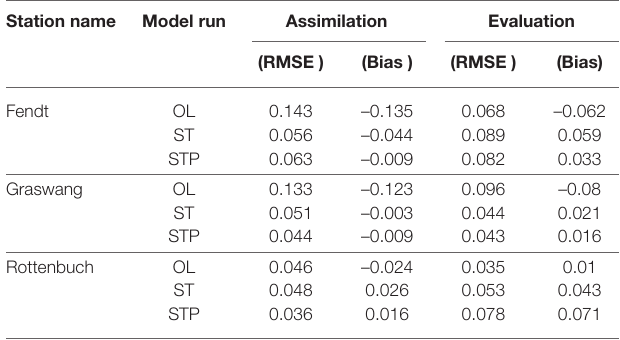
Figure 4 . The standard Noah-MP configuration uses a constant value (rk3.0) for REFKDT (Eq 1). At simulation initialization,